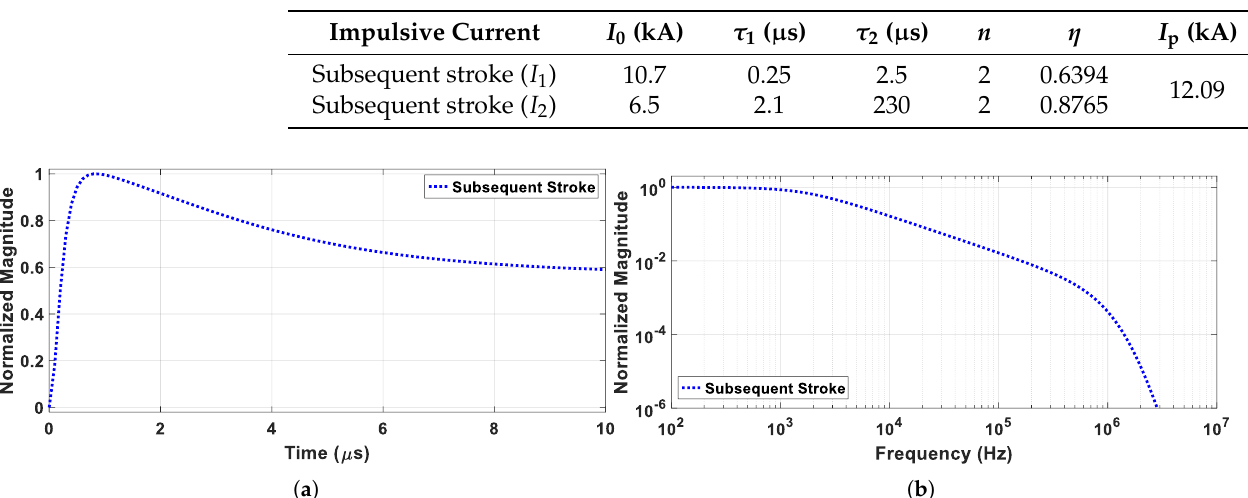
Table 1. Parameters for lightning subsequent stroke current.